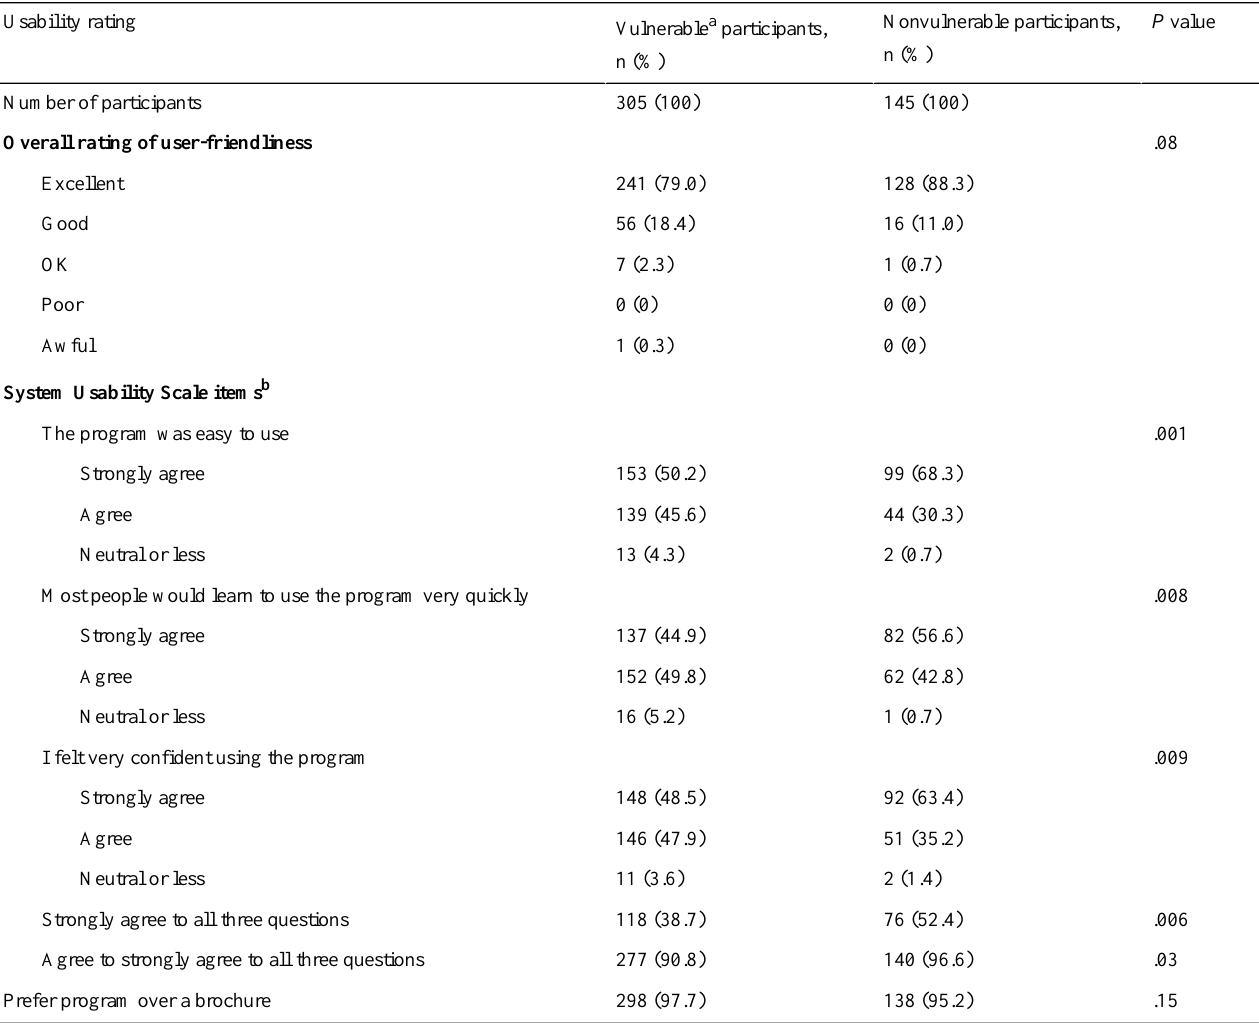
Table 2. Participant-rated usability of the mPATH mHealth